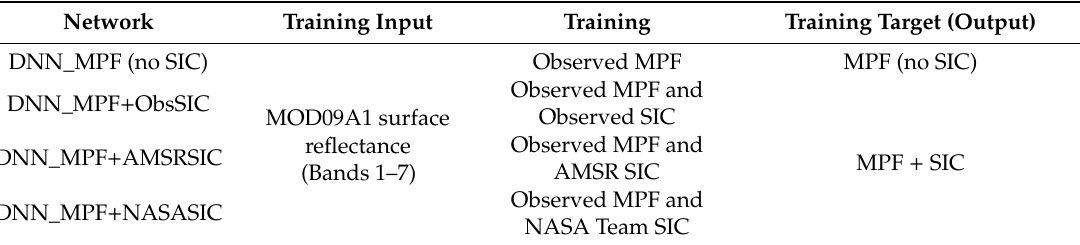
Table 2. Details of the target and output for the network.